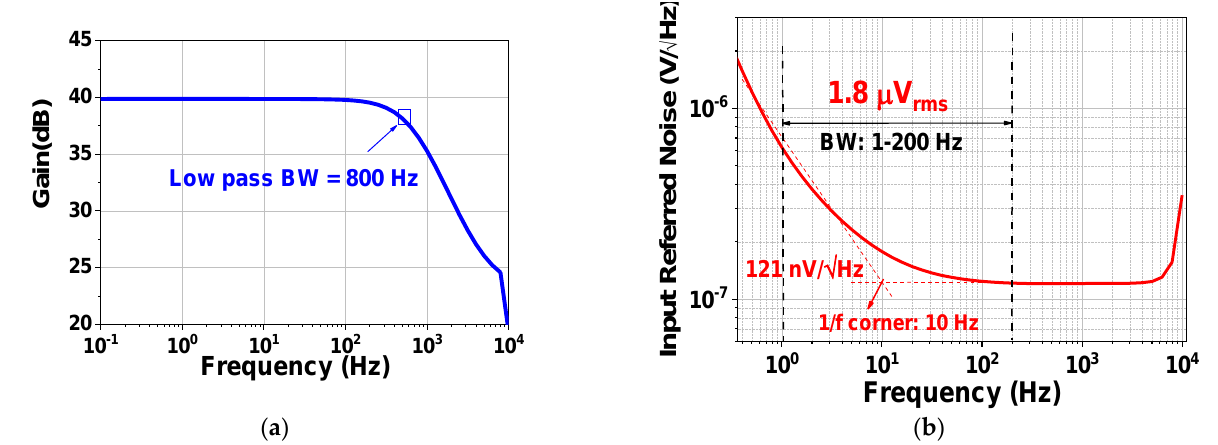
Figure 10. The simulation results of the proposed CCIA: ( a ) the frequency response; ( b ) the input referred noise.